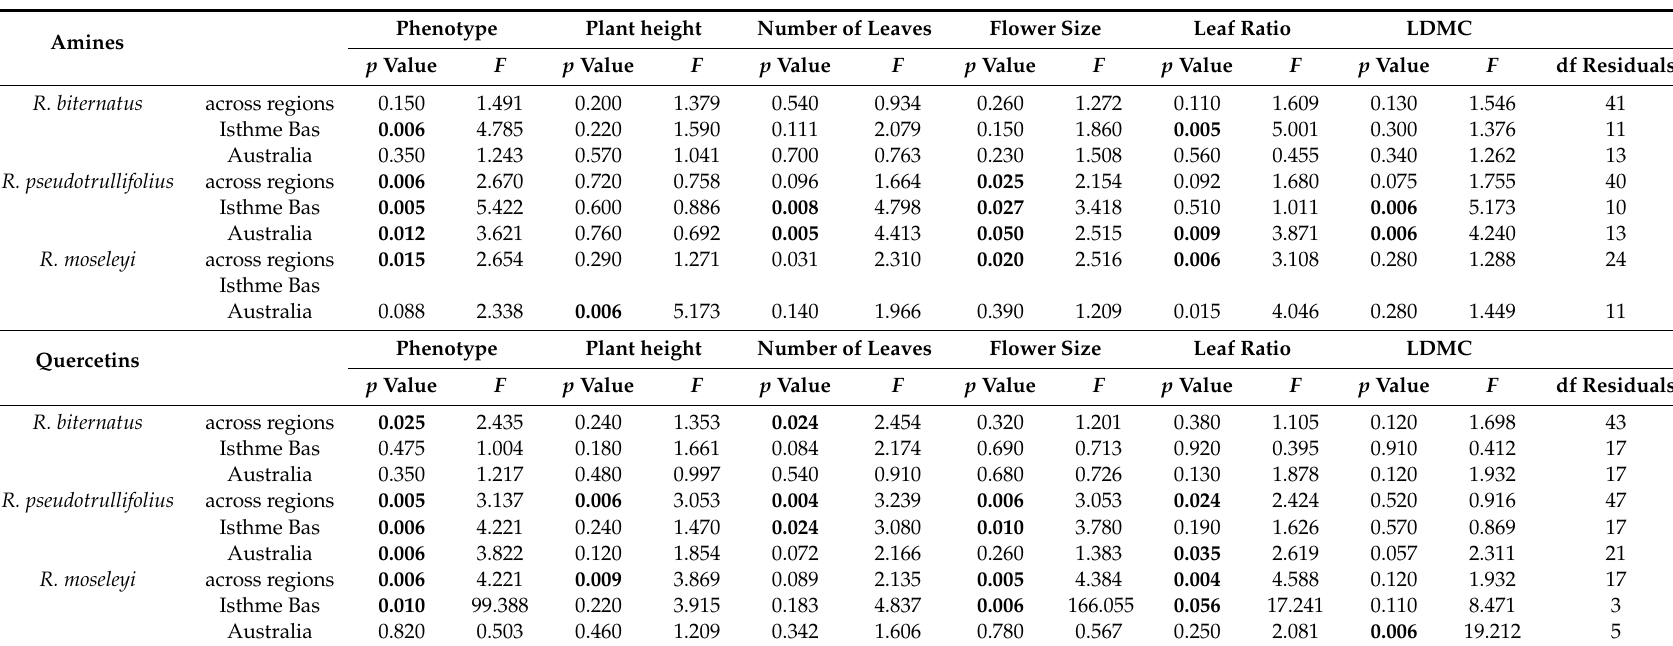
Table 4. Multivariate relationship between a given trait and compositions of either all amines or all quercetins. Multivariate multiple regression analysis relating a given trait to levels of all compounds